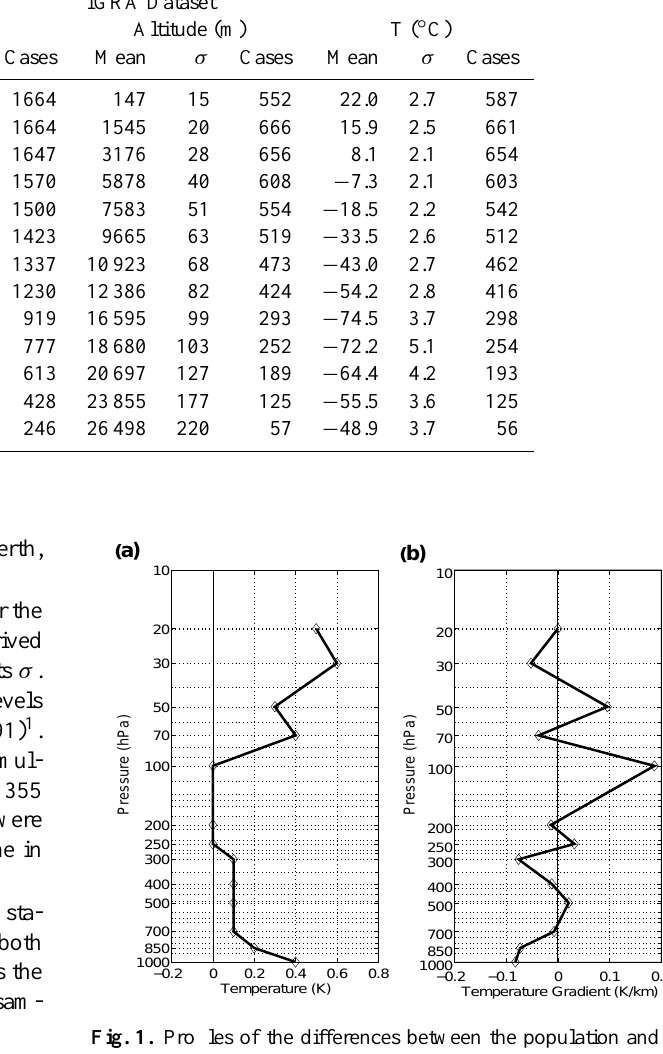
Fig. 1. In Fig. 1a the differences of the mean temperature show values of 0.4 K at 1000 hPa, decreasing to the middle troposphere. Between 700 and 100 hPa the differences are 0.1 K, with no differences in the layer from 250 to 100 hPa, around the tropopause. Then the mean temperature differ- ences increase above the tropopause reaching its larger val- ues on the top of the profiles. Such relative higher differ- ences values on top of the sounding are associated with the 80% of the missing data in that layers in comparison with the 60% in the lower ones. In general the magnitudes of the differences are below or equal to 0.6 K, with the mean tem- peratures showing higher values in the population than in